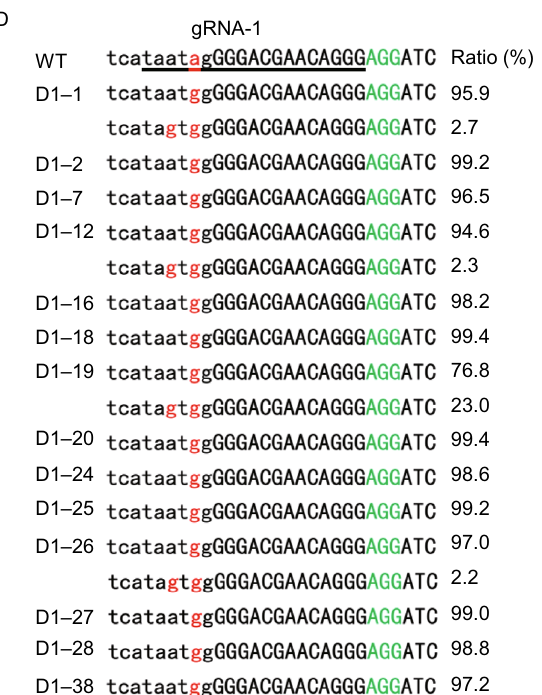
Figure 1. Ef fi cient targeting of the mouse Dmd gene by adenine base editors (ABEs) . (A) Schematic representation of the two gRNA target sites in the Dmd gene locus. Exon-intron boundary sequences (both strands) are shown with exon sequences capitalized and intron sequences in lower case. The gRNA target sequence is underlined, with PAM in green and the adenine being mutated in red. (B) The number of injected and transplanted embryos and subsequent pup information for each gRNA group are listed in the table. (C) Representative Sanger sequencing chromatograms of PCR amplicons spanning each gRNA target site from wild-type (WT) vs. mutant mice (D1 – 12 and D2 – 22 for group gRNA-1 and gRNA-2 respectively). Red triangle marks the targeted/mutated adenine. (D) PCR amplicons span- ning the gRNA-1 target site from the F0 newborns were analyzed by deep sequencing. Exons and introns are in capital and lower caselettersrespectively.Basesubstitutions,red.PAM,green.The frequency of each mutant allele within individual pups is listed on theright.(E)PCRampliconsspanningthegRNA-2targetsitefrom the F0 newborns were analyzed by deep